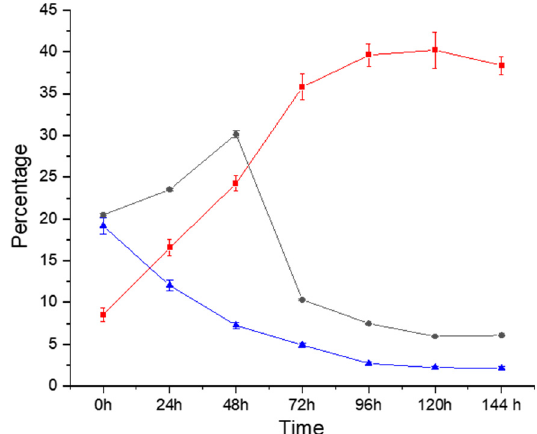
Figure 2. Percentage of protein, soluble and insoluble sugars detected during the fermentation process. Red square: crude protein; blue triangle: insoluble sugar; grey circle: soluble sugar. Results are expressed as percentage calculated on dry matter.